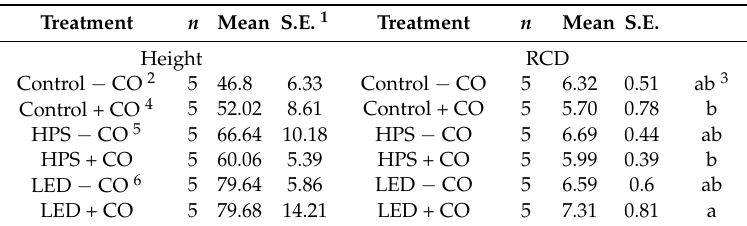
Table 2. The interactive effects of lighting spectra and chitosan oligosaccharide addition on height and root-collar diameter (RCD) in Fragrant rosewood ( D. odorifera ) seedlings.